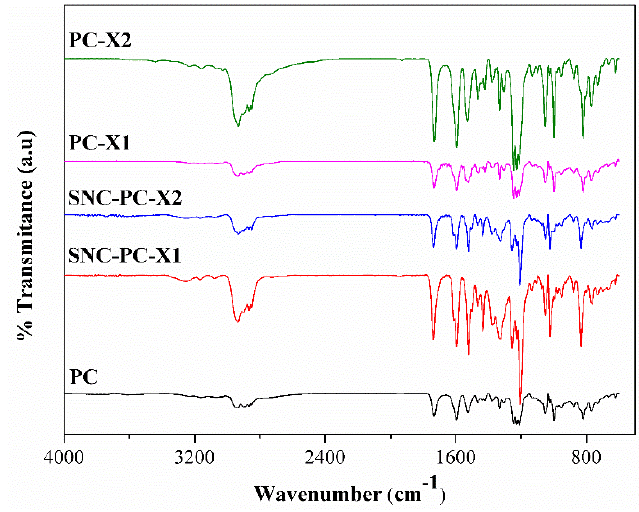
Figure 3. FTIR spectra of PC, PC-X1, PC-X2, SNC-PC-X1 and SNC-PC-X2.